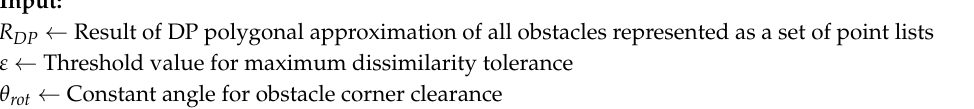
Algorithm 4. Pseudo Code of EDP (Detailed